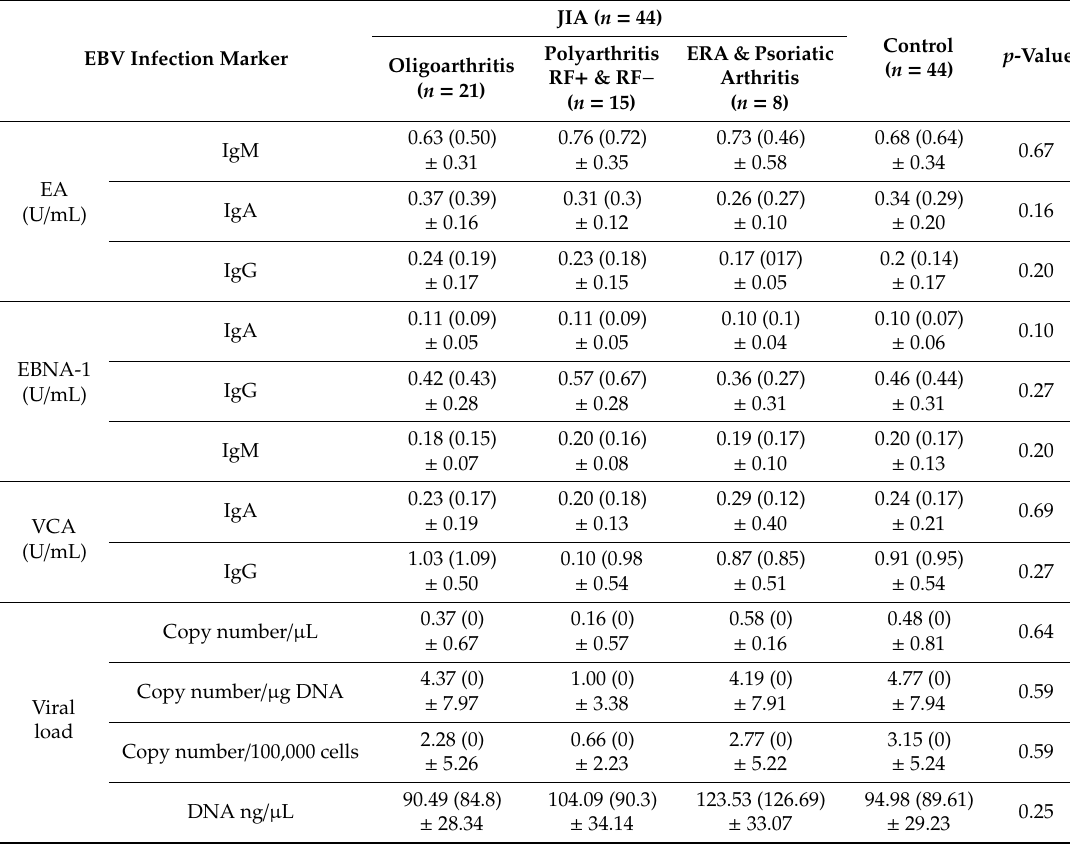
Table 3. Serum concentrations of infection markers in patients with di ff erent types of JIA and controls. Results are presented as mean (median) ± standard